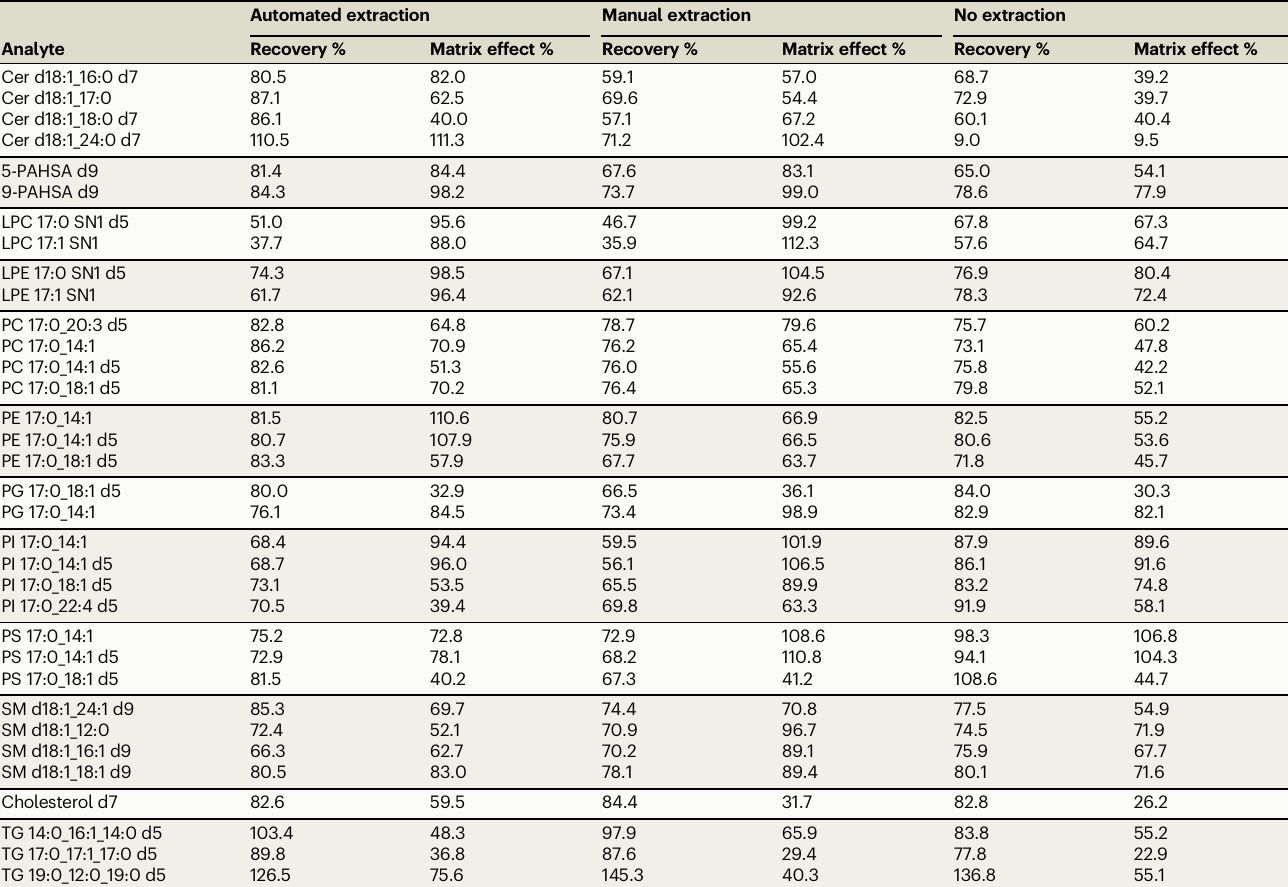
Table 1 | Recovery and matrix effects for NIST plasma SRM automated extraction vs manual Automated extraction Manual extraction No extraction Analyte Recovery % Matrix effect % Recovery % Matrix effect % Recovery % Matrix effect